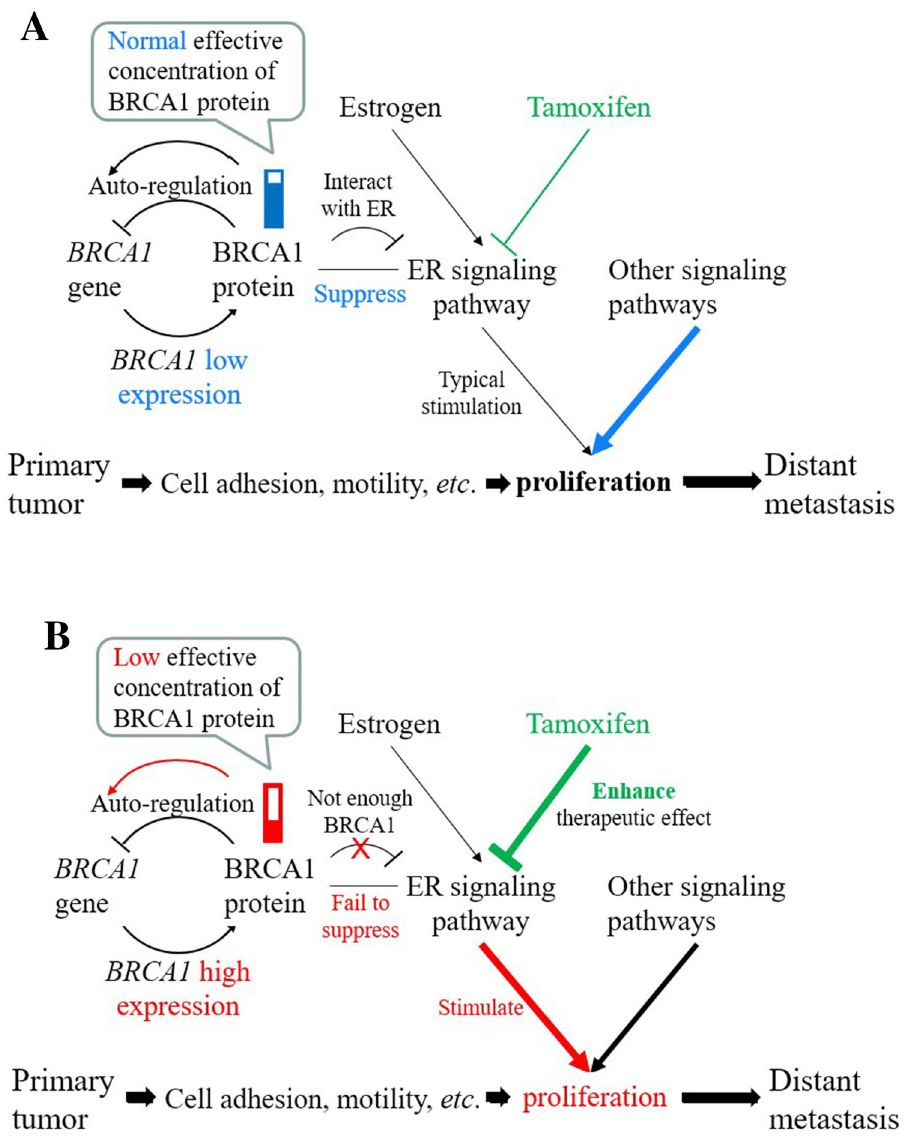
Figure 6. A comprehensive interpretation to link our observations and literature reports. This figure was drawn by Microsoft PowerPoint version 14.6.2 (https:// www. micro soft. com/ en- us/ micro soft- 365). ( A ) The pathway for the primary tumor to develop DM under the condition of sufficient BRCA1 protein (leading to low BRCA1 expression via autoregulation). ( B ) The pathway for the primary tumor to develop DM under the condition of low effective BRCA1 protein concentration (leading to high BRCA1 expression via